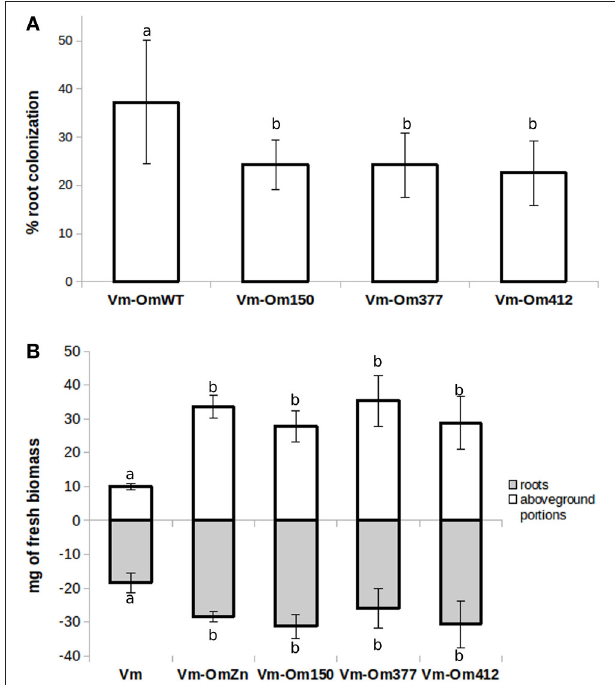
FIGURE 6 | Om 1 SSP1 mutants have a reduced capability to colonize V. myrtillus roots. V. myrtillus roots were observed after 1.5 months of co-culture with O. maius WT and with three OmSSP1 null-mutant strains. (A) The percentage of the root colonization was significantly lower for the OmSSP1 null-mutants as compared to the O. maius WT. (B) Quantification of fresh plant biomass (roots - gray bars - and aboveground portions - white bars) of V. myrtillus plants grown alone, in the presence of the O. maius WT strain or of the OmSSP1 null-mutants. Bars represent the mean ± SD, n = 5. Each biological replicate represents the total biomass of eight V. myrtillus seedlings grown in an individual plate. Different letters indicate statistically significant difference ( p < 0.05, ANOVA, Tukey’s post hoc